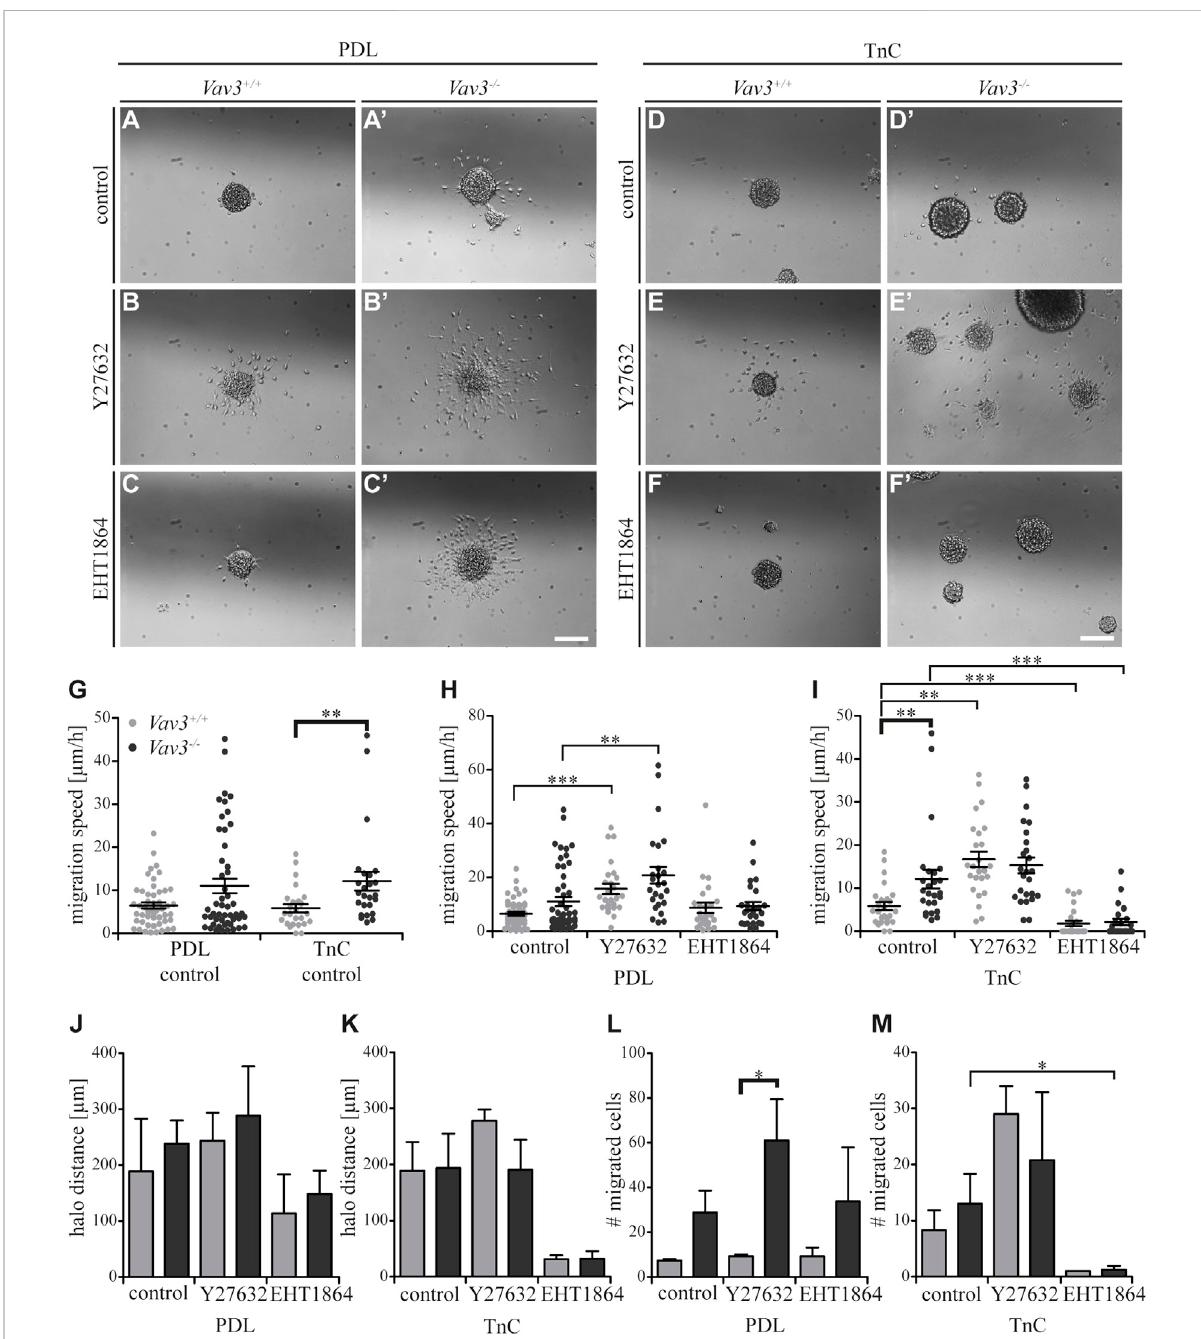
FIGURE 6 Effect of inhibited Rho GTPase signalingon OPC migration onPDL and tenascins. (A +A 9 ) Control condition of oligospheres of either genotype on PDL without treatment (after 24 h). (B + B 9 ) Blockage of ROCK by treating oligospheres of both genotypes on PDL with the inhibitor Y27632 after 24 h. (C + C 9 ) Blockage of Rac1 by a treatment of oligospheres of both genotypes on PDL with the inhibitor EHT 1864 after 24 h. (D + D 9 ) Control condition of oligospheres of either genotype on TnC without treatment (after 24 h). (E + E 9 ) Blockage of ROCK by a treatment of oligospheres on TnC with the inhibitor Y27632 after 24 h. (F + F 9 ) Blockage of Rac1 by treating oligospheres of both genotypes on TnC with the inhibitor EHT 1864 after 24 h. (G) Quanti fi ed migration speed of PDL and TnC control conditions without treatment. A signi fi cantly lower migration speed was observed for Vav3 +/+ OPCs compared to Vav3 − / − on TnC, whereas velocities on PDL compared to TnC were similar ingeneral. (H) The quanti fi cation ofthemigration speedofOPCs indicated aRhoArelated migrationbehavior onPDL, withsigni fi cantly higher velocitiesseen after ROCK inhibition in both genotypes. (I) The quanti fi cation of the migration speed of OPCs from oligospheres of either genotype on TnC indicated a strong Rac1- dependent and also RhoA-related migration speed. (J) The halo distance slightly supported a restrained involvement of RhoA in migration behavior of OPCs of either genotype on PDL. Inhibition of Rac1 caused a decreased halo distance that was statistically not signi fi cant. (K) The halo distance of